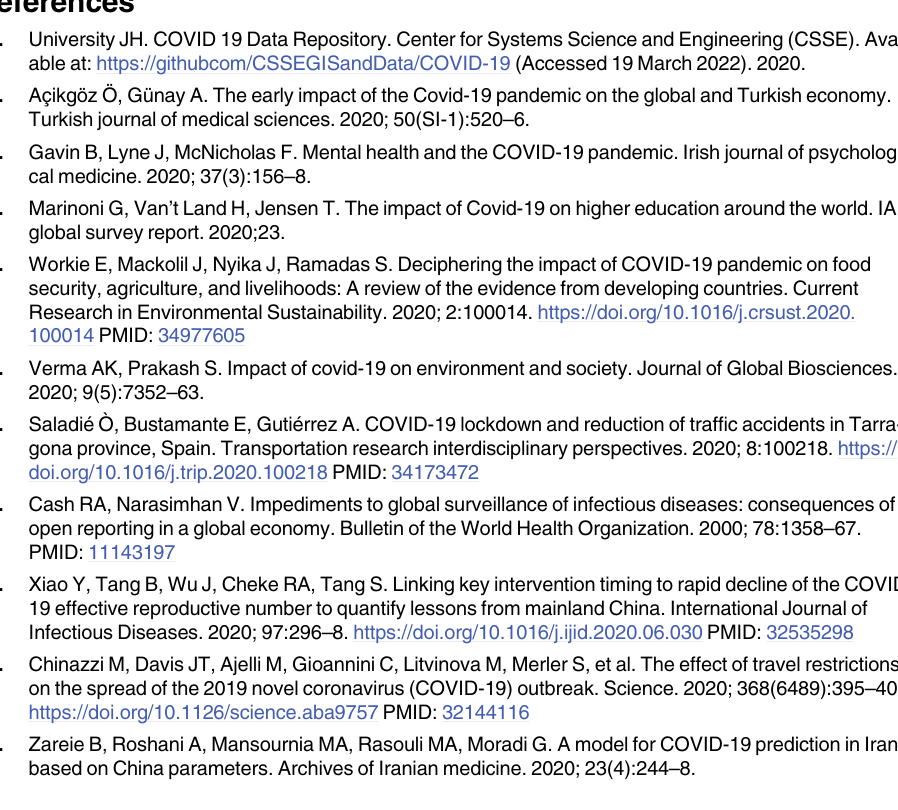
S1 Table. Weekly new COVID cases forecasting models, comparing ARIMA